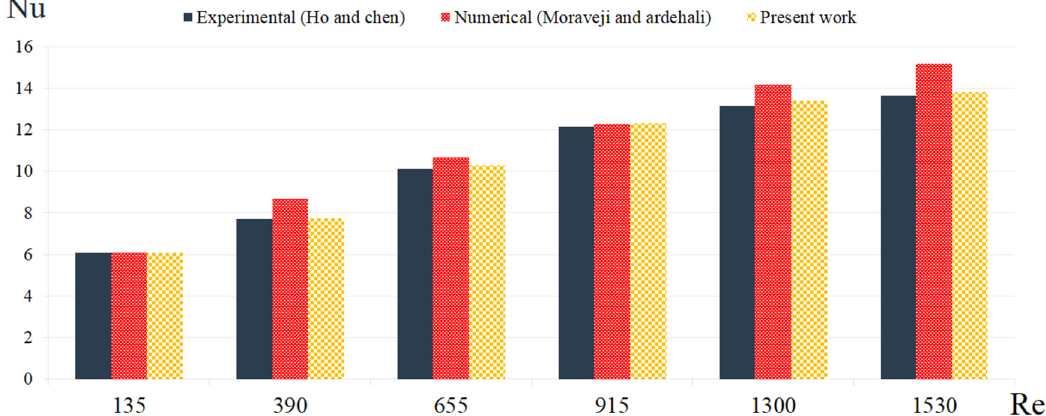
Figure 3. Results of current study in comparison of the literature [43] (experimental) and [39] (numerical).